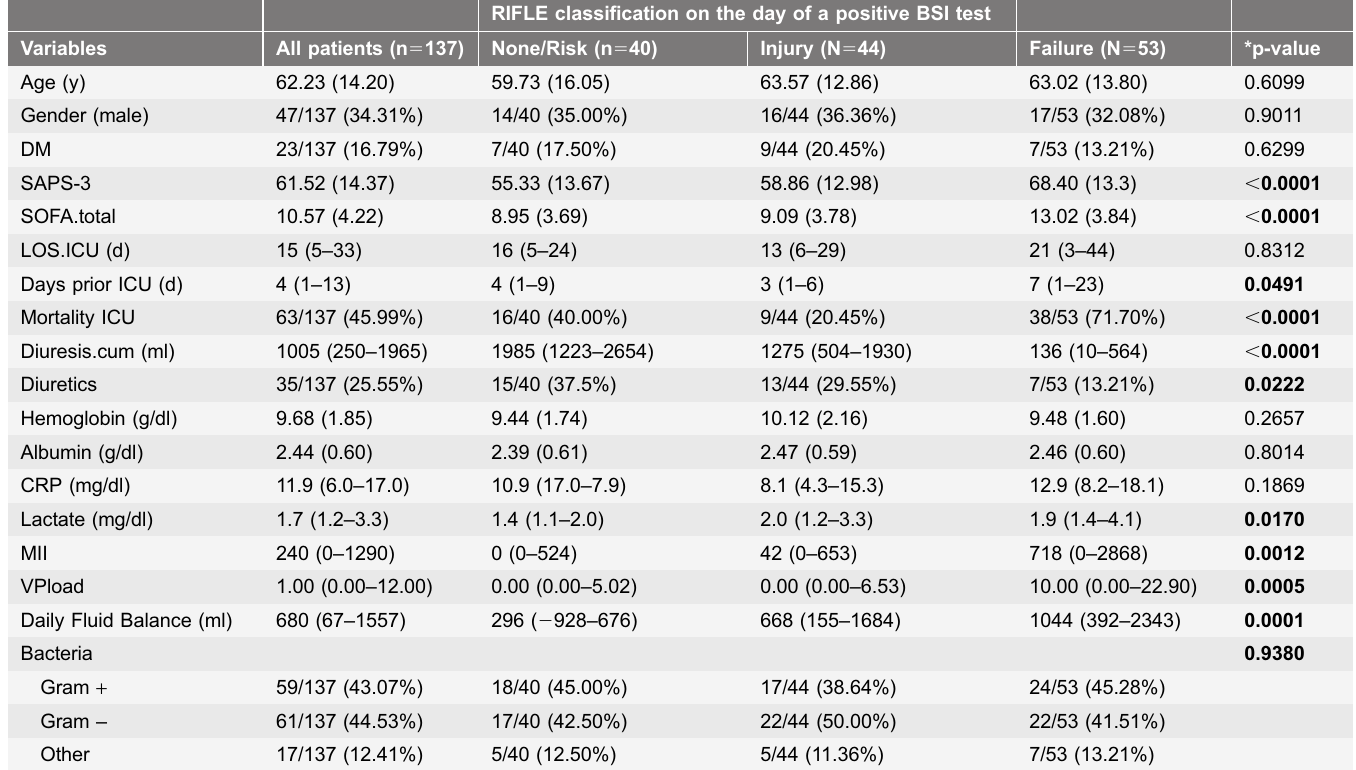
Table 1. Patient characteristics according to the RIFLE criteria.